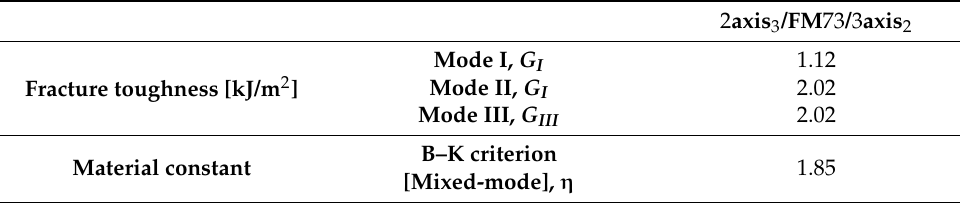
Table 6. Fracture toughness test results of hybrid